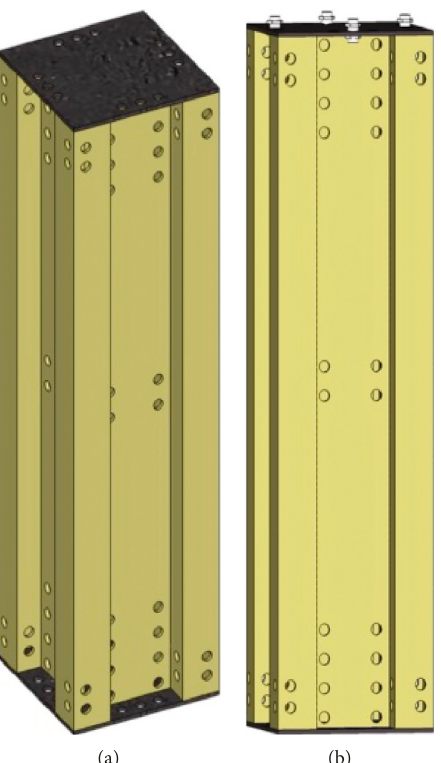
Figure 10: Holes for connections in basic units 1 (BU1). Total number of holes: 168. (a) Holes in BU1 (side view); (b) holes in BU1 (front